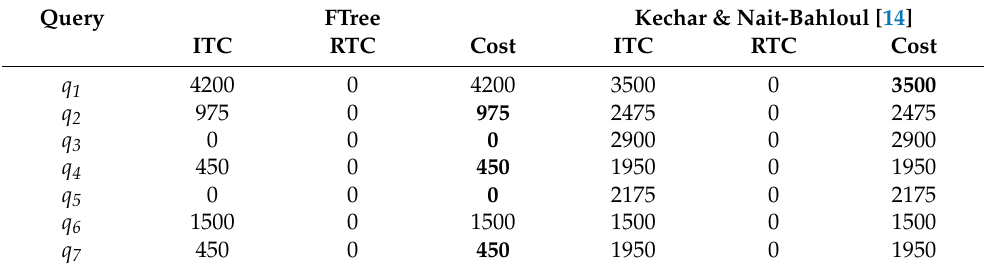
Table 17. Comparison of query costs for the two fragmentation